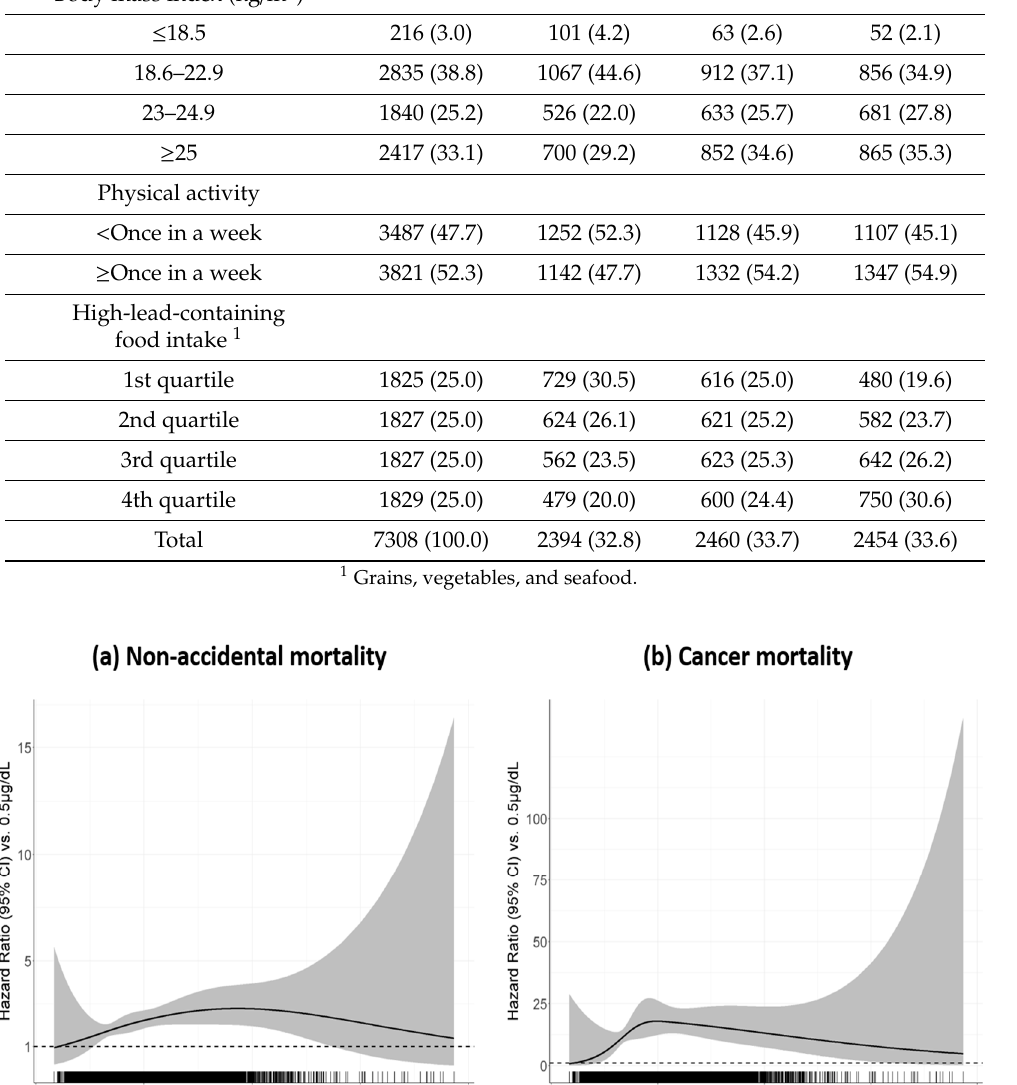
Table 2. Hazard ratio (95% CI) of non-accidental and cancer mortality associated with tertile of blood lead.